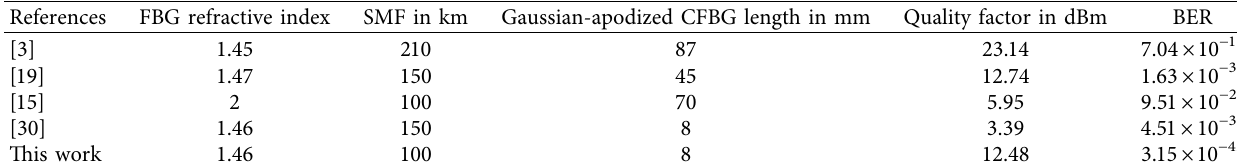
Figure 10: Eye-diagram graph for four-stage Gaussian-apodized FBG+DCF Table 7: Comparison of different designs using the apodized chirped Gaussian profile.